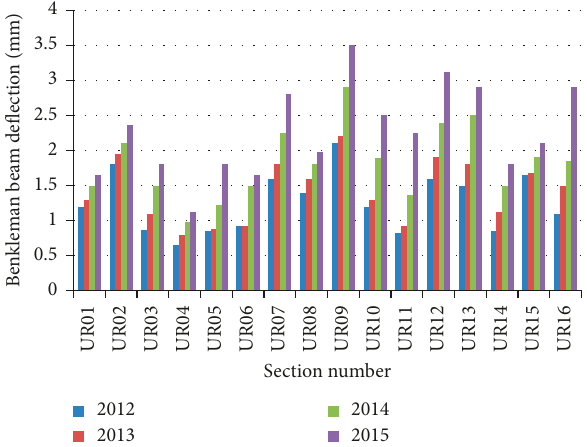
Figure 3: Measured BBD for the road sections UR01 to